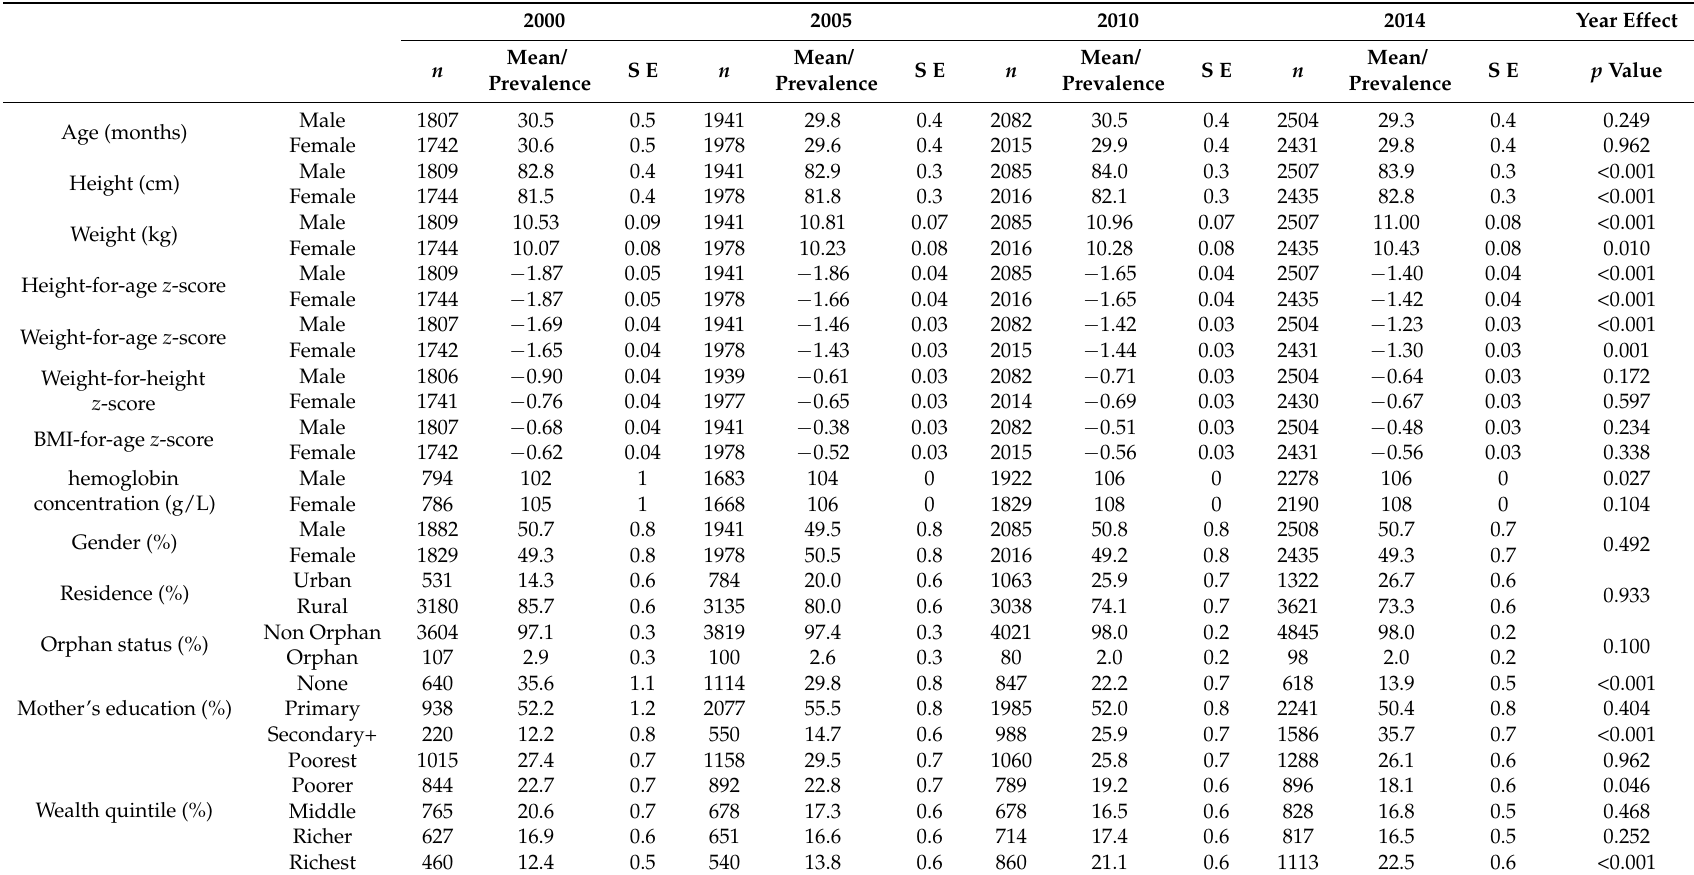
Table 1. Characteristics of children included in the analysis from the Cambodian DHS surveys of 2000, 2005, 2010, and